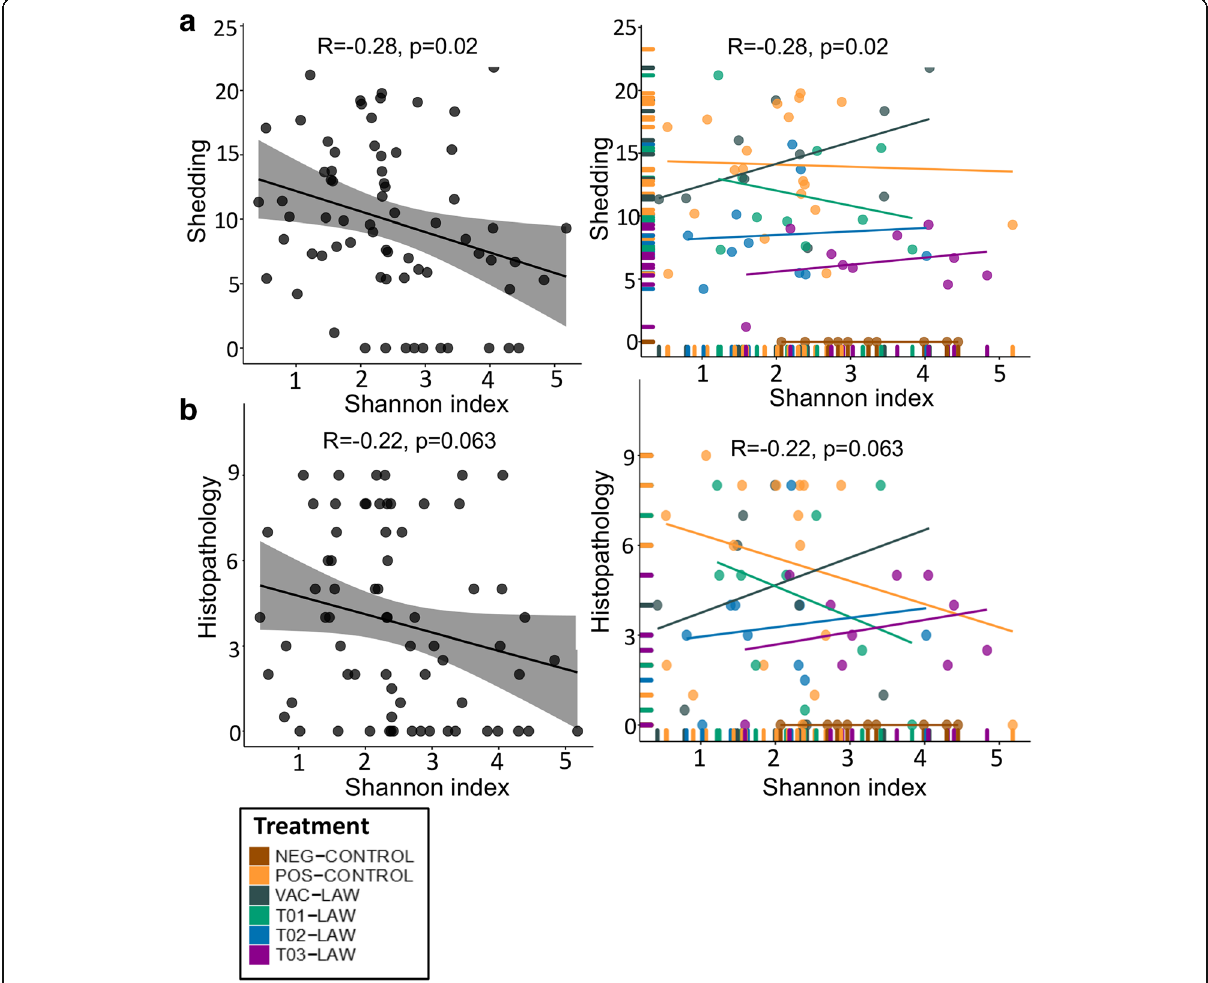
Fig. 5 Relationship between L. intracellularis phenotype, including a shedding and b histopathology (microscopic ileum score), and their corresponding ileal microbiota diversity. Groups are colored by treatment and R represents the correlation coefficient and the corresponding p